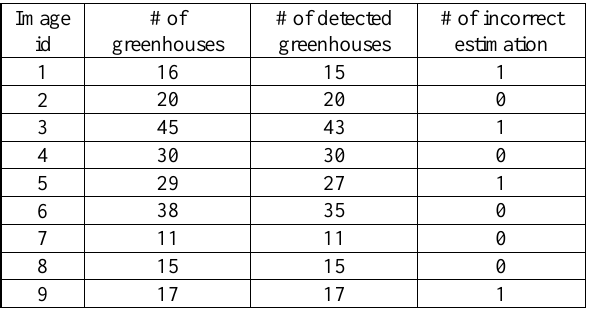
Table 1. Numerical information for different